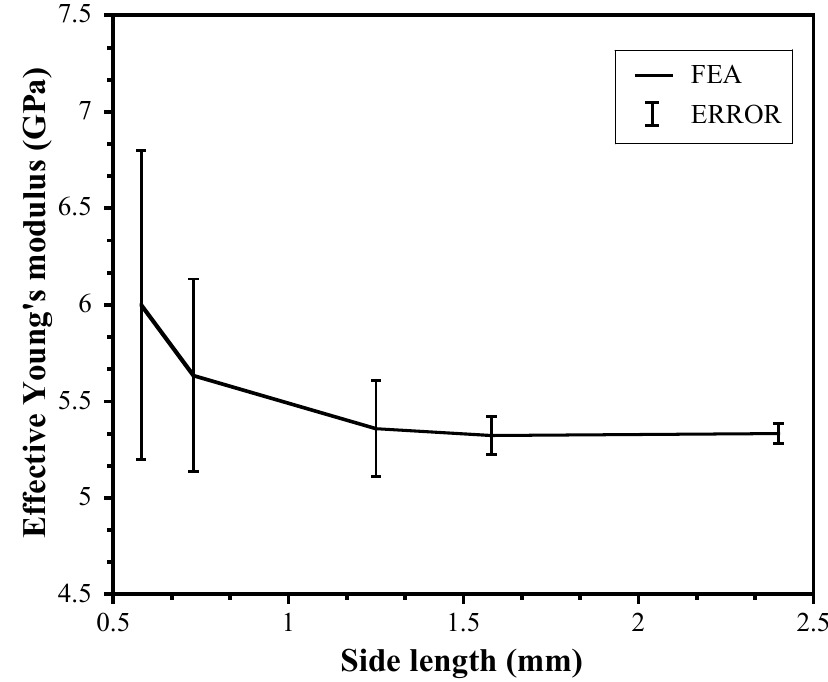
Figure 6. Variation of the effective Young’s modulus with change in RVE side length.